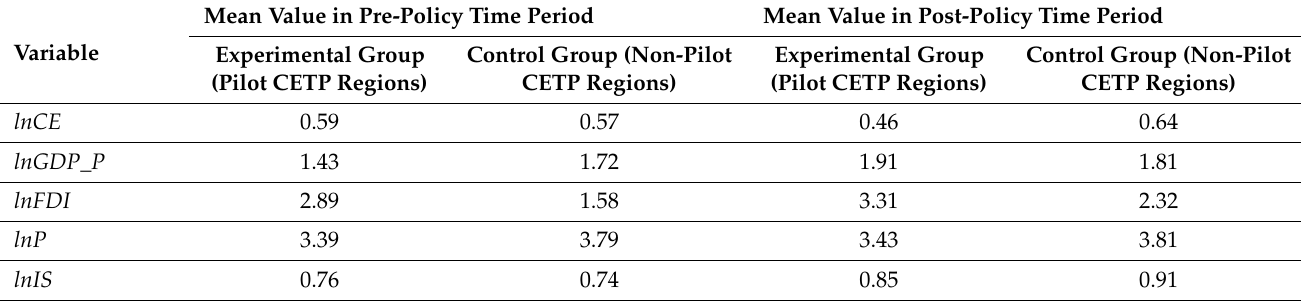
Table 2. Comparative analysis of variables’ mean